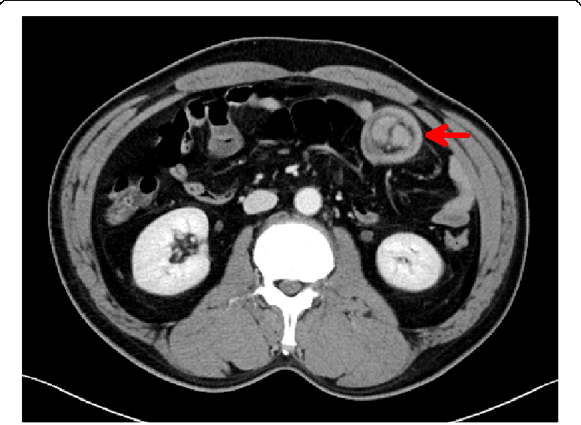
Fig. 2 CT scan showing a target sign at the jejunum